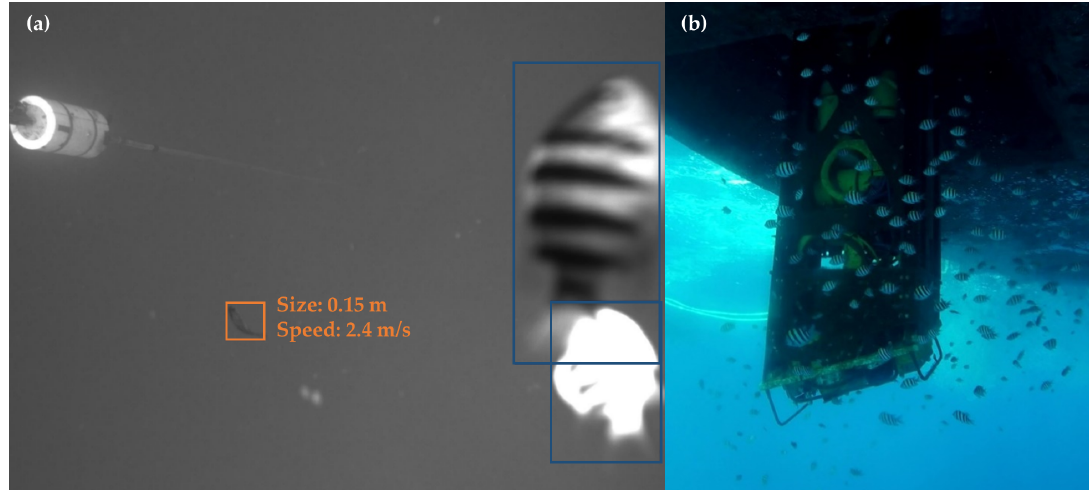
Figure 11. ( a ) Automated size and speed estimation from WAMP deployment imagery. Size is reported as the diagonal length of predicted 3D bounding box. The reef fish on the right margin have been automatically identified as not of interest. ( b ) Representative reef clutter observed by external camera during WAMP